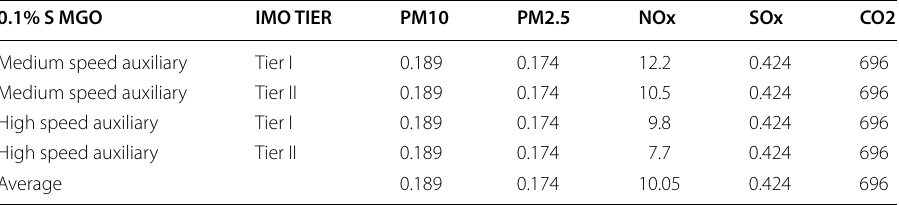
Table 3 Emission factors of selected pollutant categories for auxiliary engines (g/kWh). Source : Starcrest 2021a; 2021b